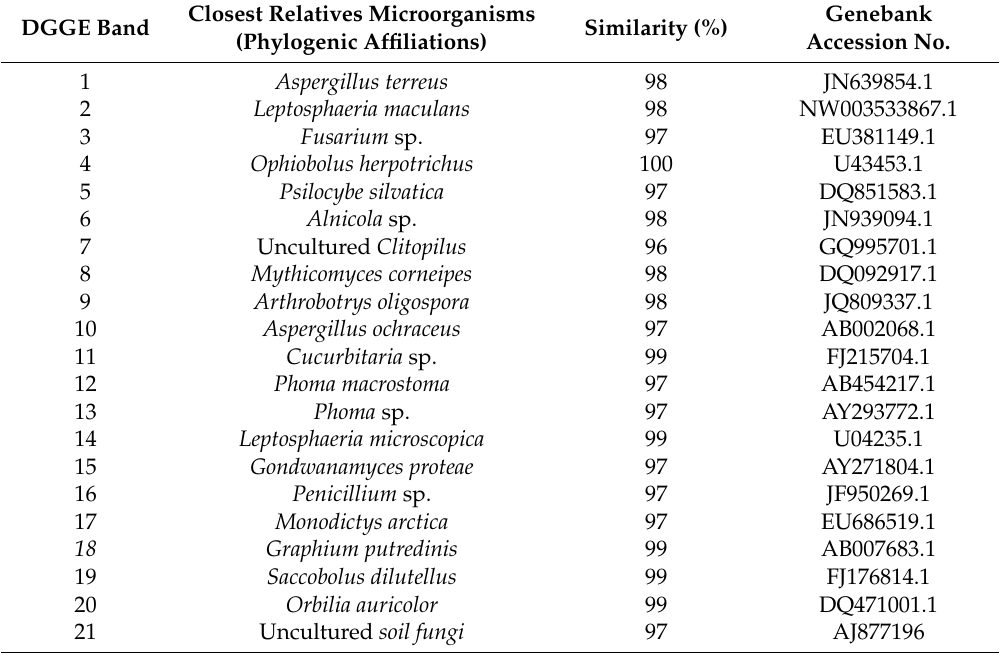
Table 5. Phylogeny of sequences present in the 18S rRNA amplicons